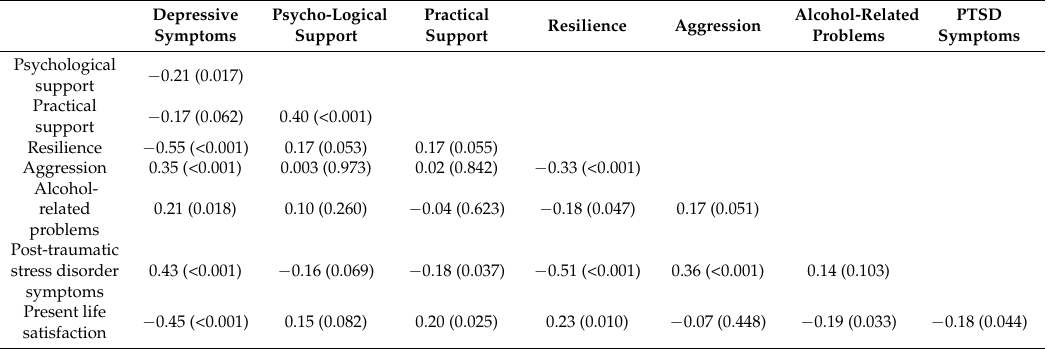
Table 5. Correlations between the measured